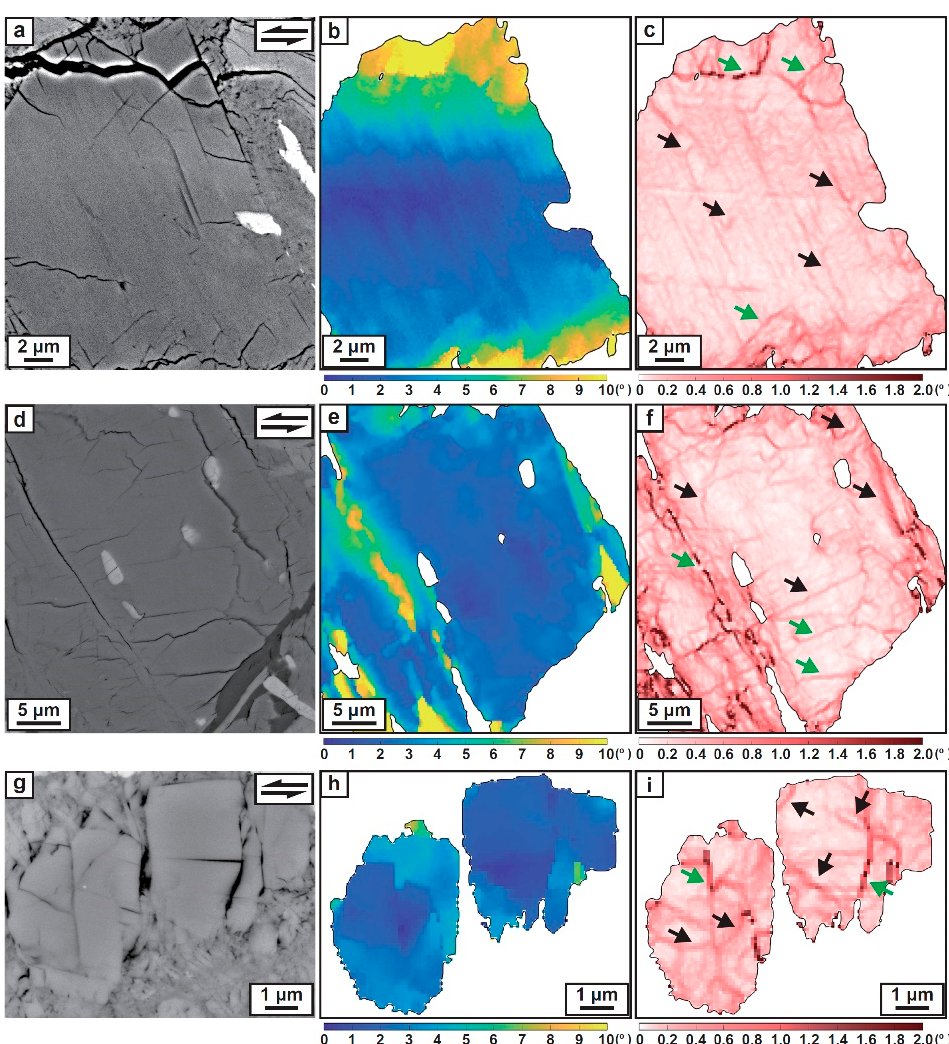
Figure 6. BSE image, grain reference orientation deviation (GROD) angle map (mis2mean), and kernel angle misorientation (KAM) map showing the intracrystalline deformation microstructure of glaucophane deformed under a shear strain of ( a – c ) γ = 0.8 (in JH88b, P = 1.5 GPa, and T = 400 °C), ( d – f ) γ = 0.6 (in JH98b, P = 1.5 GPa, and T = 500 °C), and ( g – i ) γ = 4.5 (in JH94a, P = 1.5 GPa, and T = 400 °C). Black arrows in the BSE images indicate the left-lateral (sinistral) shear sense. Black and green arrows in the KAM map indicate the local plastic strain (i.e., dislocation density or rotation of the lattice) and the tilted crystal orientation by brittle fracture, respectively. Step size of mapping: ( b ) and ( c ) 0.15 μ m, ( e ) and ( f ) 0.2 μ m, and ( h , i ) 0.1 μ m. In glaucophane deformed under a low shear strain of γ = 0.6 at a pressure of 1.5 GPa and high temperature of 500 °C (JH98b), the GROD angle map illustrated that the high misorientation focused on the fracture in the grain (Figure 6e). However, the KAM map presented well-preserved misorientation lines, irrelevant to the fractures (Figure 6f). For glaucophane deformed under a high shear strain of γ = 4.5 at a pressure of 1.5 GPa and temperature of 400 °C (JH94a), regardless of the cataclastically comminuted grain, the KAM map showed that several misorientation lines were present in the remaining relatively large grains (Figure 6i).